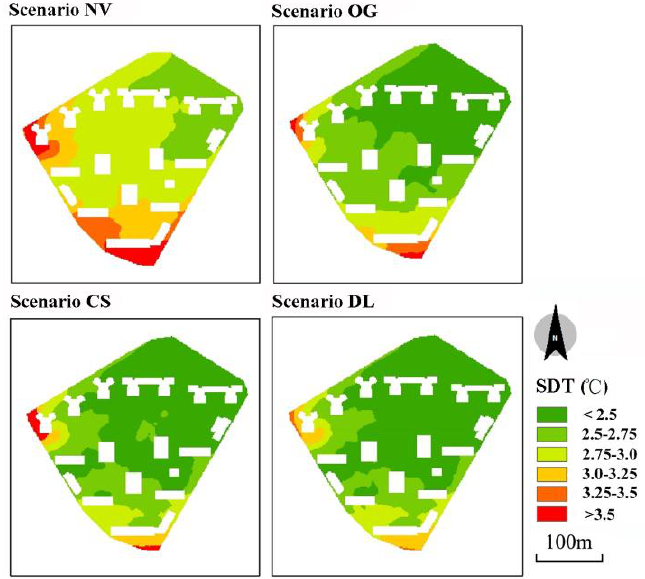
Figure 7. Standard deviation of air temperature at 1.5 m above ground at grid level from 8:00 to 20:00. SDT = standard deviation of air temperature. NV, OG, CS and DL are short for No Vegetation, Only Grass, Current Situation and Double LAD, respectively.